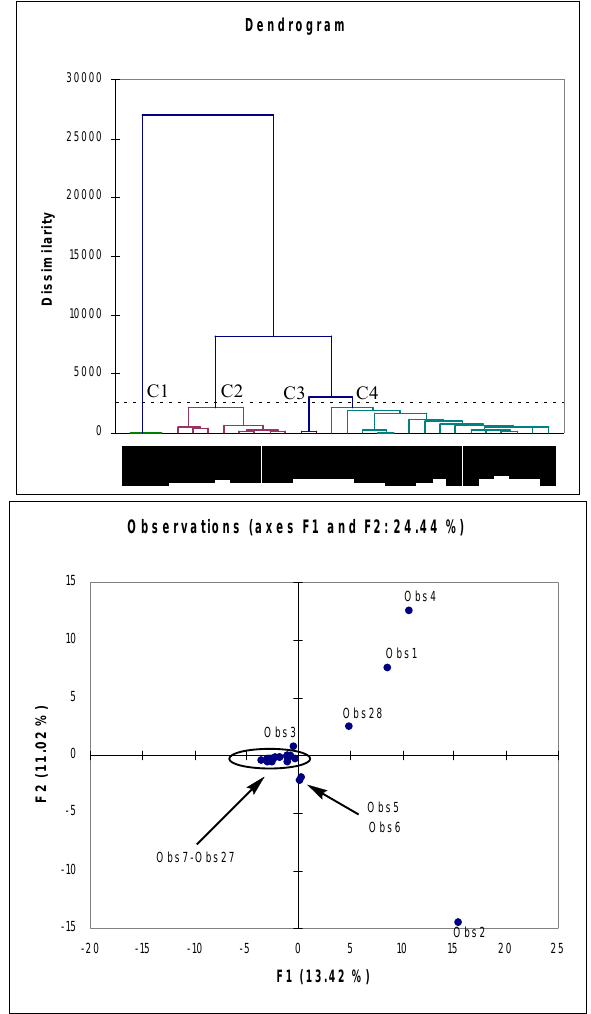
Figure 1. (a) Dendrogram (AHC analysis) representing chemical composition dissimilarity relationships of 28 essential oil samples (observations) obtained by Euclidian distance dissimilarity (dissimilarity within the interval [0, 27000], using aggregation criterion- Ward's method). Four groups of samples (C1-C4) were found. (b) Principal component analysis ordination of 28 oil samples (observations). Axes (F1 and F2 factors-the first and second principal component) refer to the ordination scores obtained from the samples.